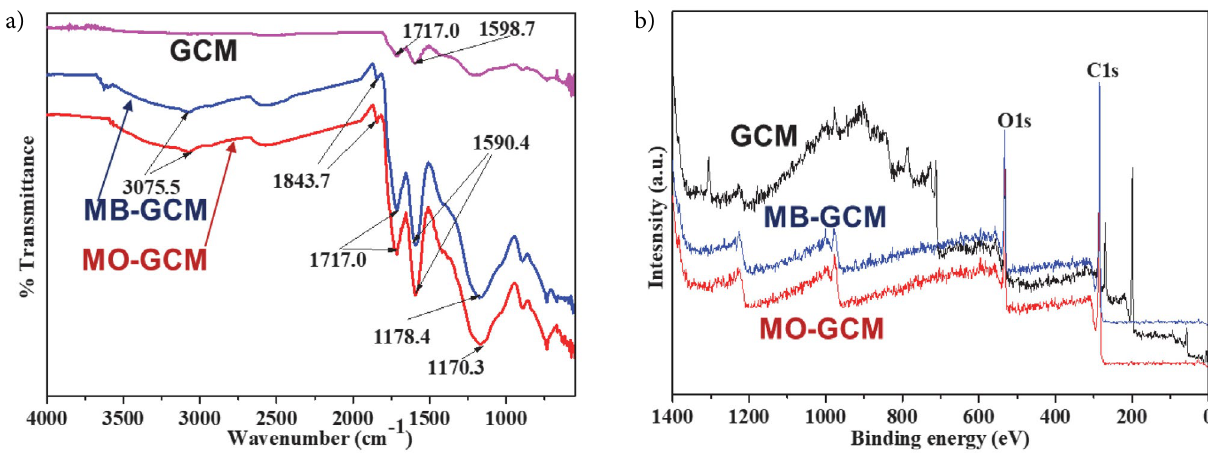
Figure 3. FT-IR spectra (a) and XPS spectra (b) of GCM and dyes loaded